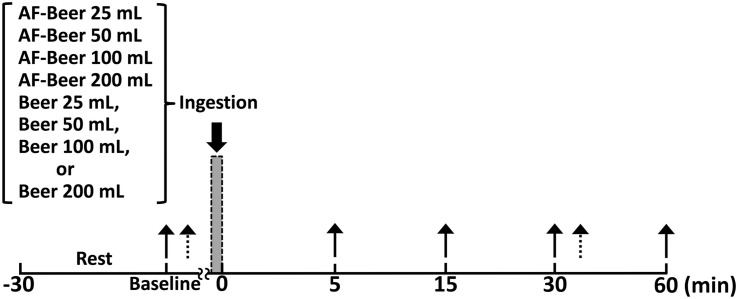
Time course of the experiment. Solid arrows: time points of measured breath alcohol level, heart-brachial pulse wave velocity, brachial-ankle pulse wave velocity, heart-ankle pulse wave velocity, cardio-ankle vascular index, and hemodynamics; broken arrows: time points of measured carotid-femoral pulse wave velocity; AF-Beer: alcohol-free beer.